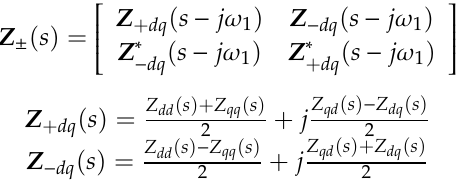
Figure 5. The whole block diagram of transfer matrices of DFIG with VSG control in synchronous dq - dq frame.